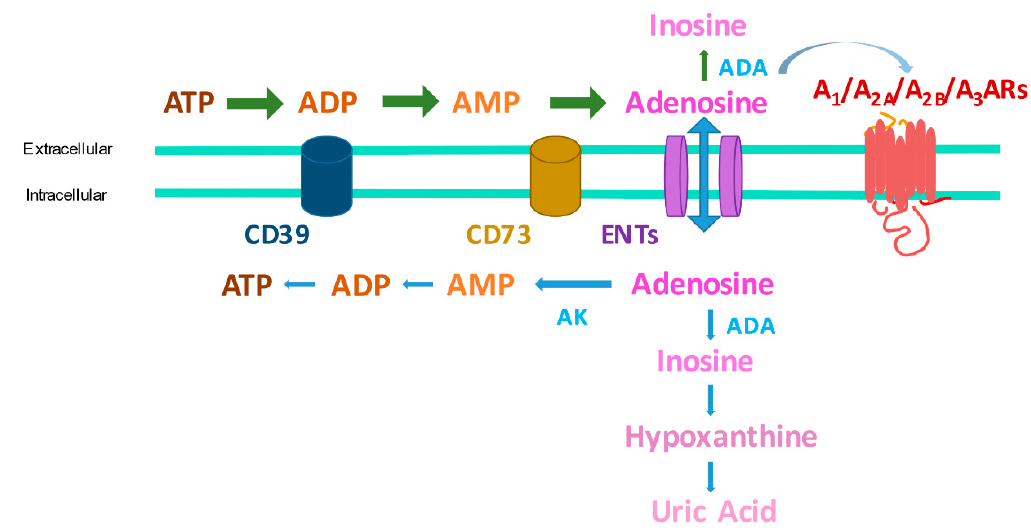
Figure 1. Adenosine metabolism and transport in the extracellular and intracellular milieu. Abbreviations: ATP: adenosine triphosphate; ADP: adenosine diphosphate; AMP: adenosine monophosphate; ADA: adenosine deaminase; AK: adenosine kinase; ENTs: equilibrative nucleoside transporters; ARs: adenosine receptors.